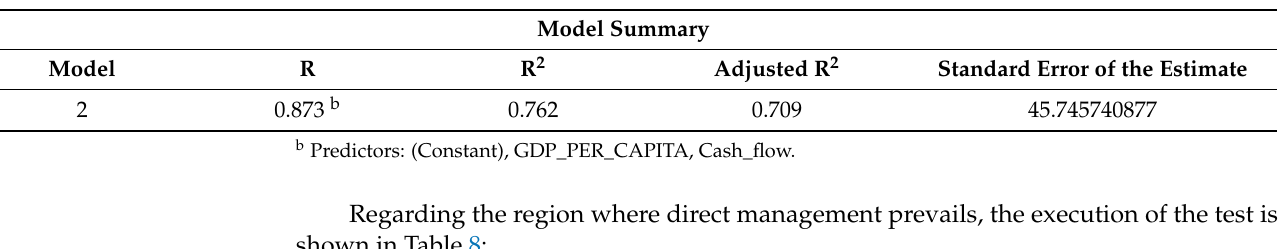
Table 7. Summary of the model for regions where management by agreement prevails. Dependent variable: expenditure per inhabitant.